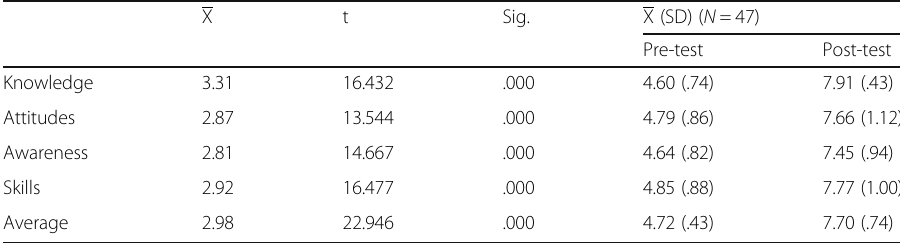
Table 6 EFL learners ’ IC – Pre-test and Post-test (Paired samples t-test) X